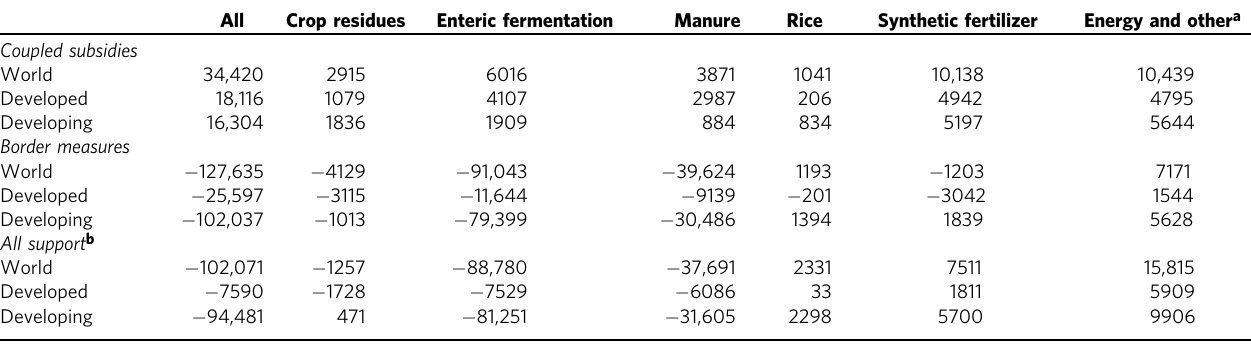
Table 4 Impact of current agricultural support (coupled subsidies and border measures) on GHG emissions from agriculture by source, 2014 – 16 (Kt of CO 2